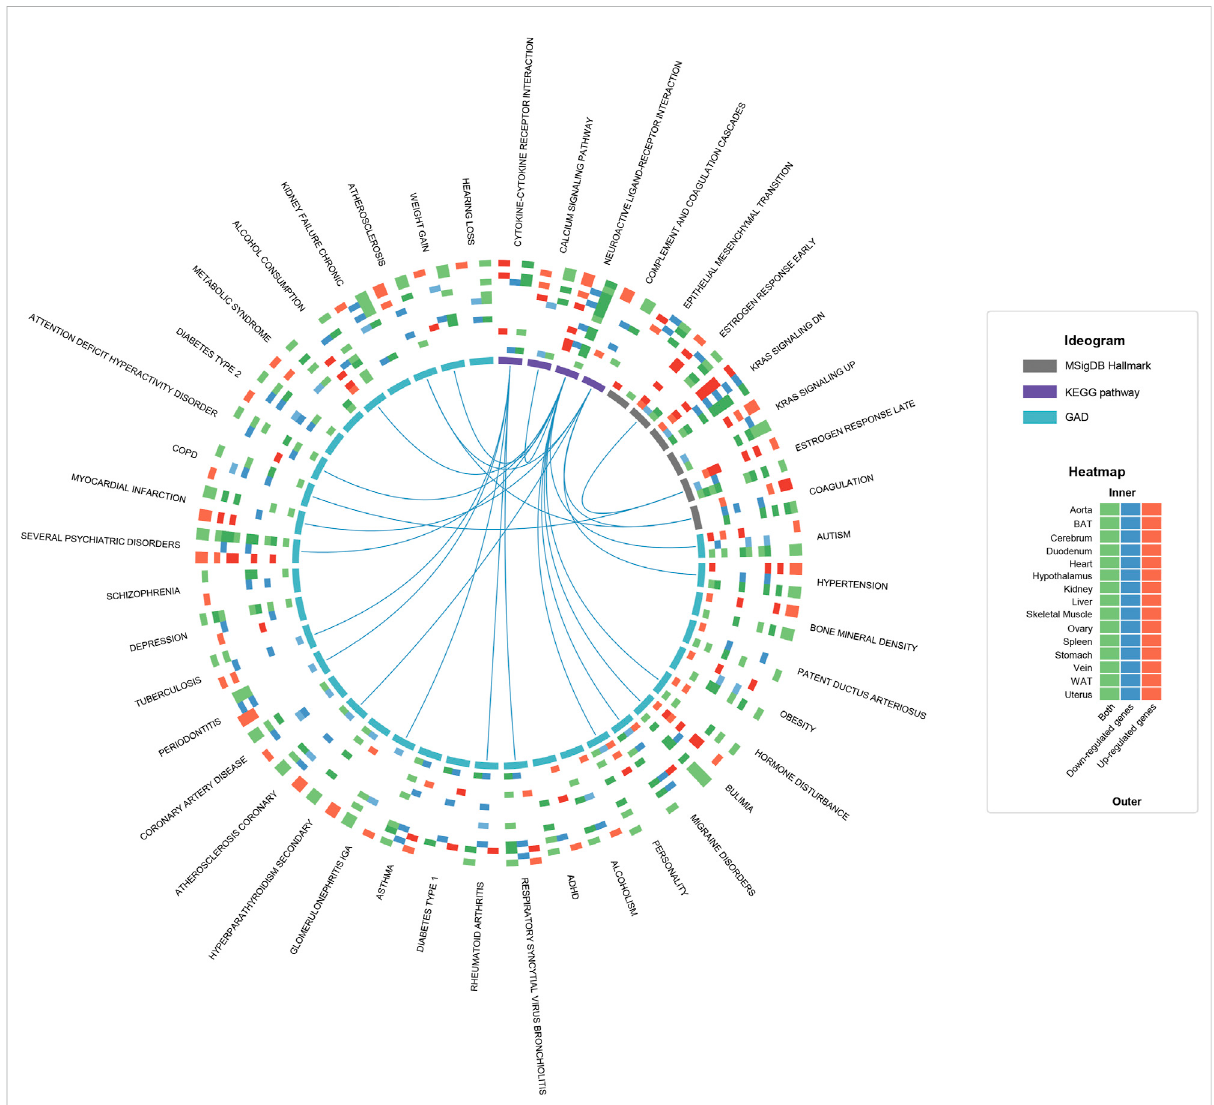
FIGURE 2 Functional enrichment analysis of hDEGs on amulti-tissue scale. The circosplot shows thestatistically signi fi cant terms(q-value ≤ 0.05) shared byatleast fi vetissuesinthefunctionalenrichmentresultsofKEGG,MSigDBHallmarkandGAD.Foreachterm,aheatmapwith15rowsand3columns is plotted, where the rows represent tissues and the columns represent up-regulated hDEGs (red), down-regulated hDEGs (blue) and both (green), respectively. The colored cells mean that the corresponding hDEG sets are signi fi cantly functionally related to the term, and the color depth re fl ects the statistical signi fi cance. The term-term links mean that the corresponding gene sets are signi fi cantly overlapped (de fi ned as sharing no less than 25% hDEGs). To avoid over-redundancy, the links between GAD terms are